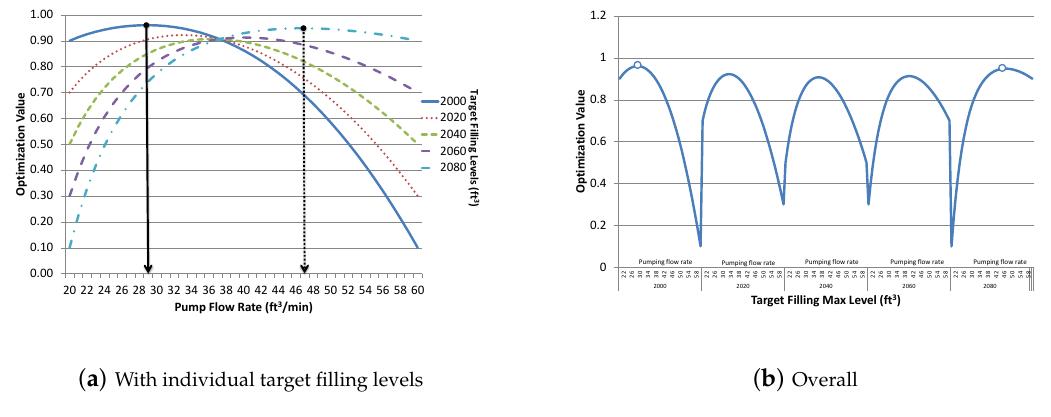
Figure 6. Optimization gain with varying tank maximum target